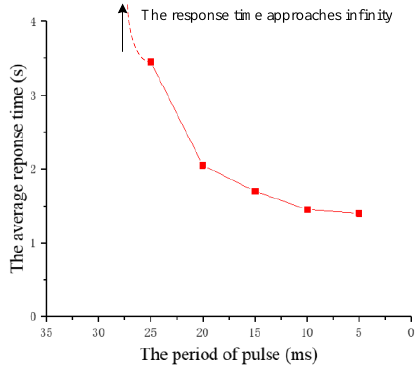
Figure 11. The relationship between the response time of beetles and the period of pulses. ( a ) The first beetle; ( b ) the second beetle.